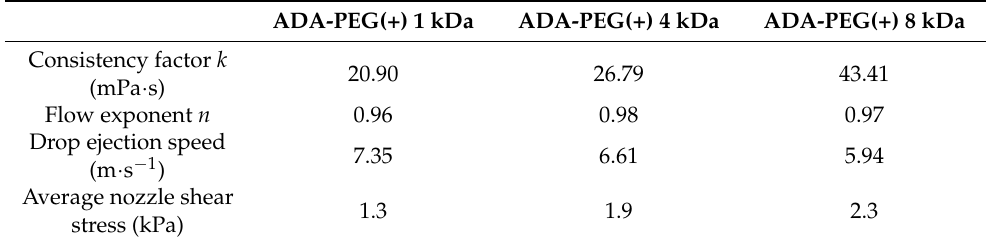
Table 1. Rheological characterization of different ADA-PEG hydrogel formulations with varying molecular weights and analytical modulation of their printing